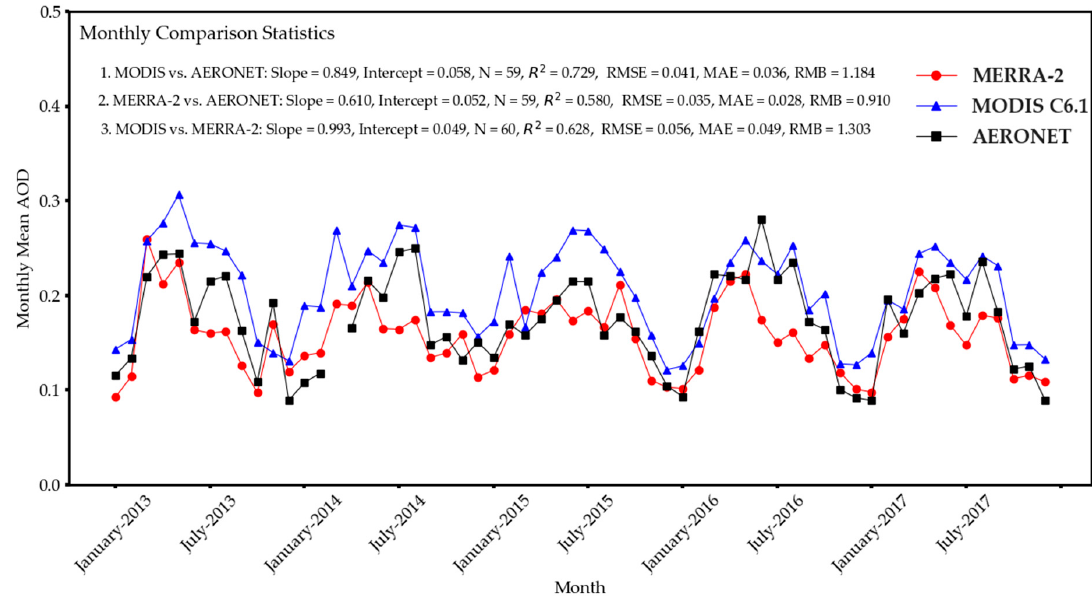
Figure 2. MERRA-2, MODIS, and AERONET monthly mean AOD, averaged according to three ground-based sites in Turkey (Section 2.2.3), and with corresponding statistics.